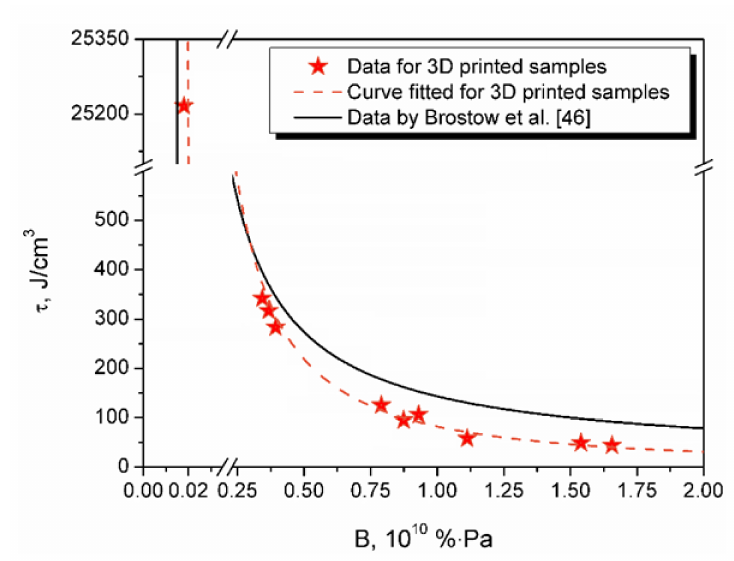
Figure 9. The plot of toughness vs. brittleness for prepared composites and literature data.